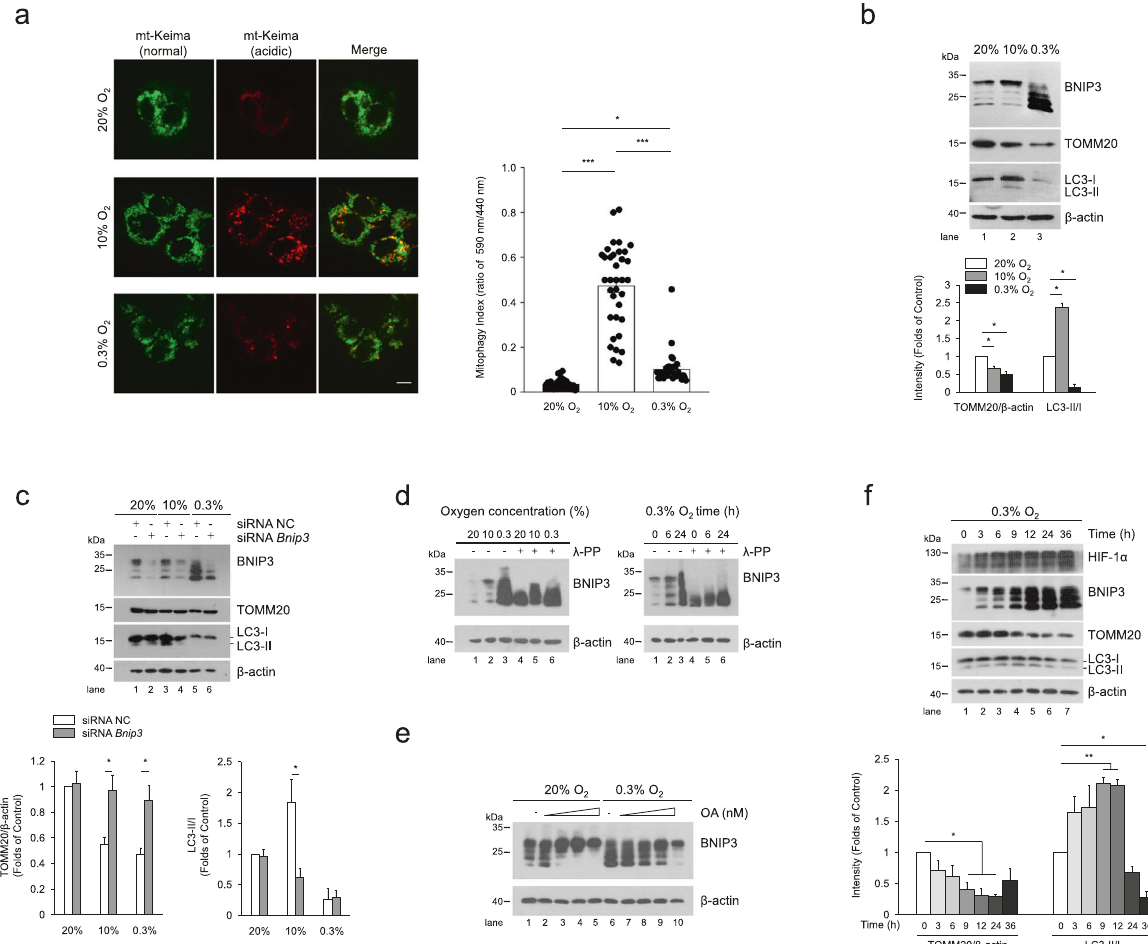
Fig. 1 BNIP3 phosphorylation is closely related to mitophagy. a PC12 cells stably expressing mt-Keima were exposed to 20% O 2 , 10% O 2 , or 0.3% O 2 for 24 h, and mitophagy was identi fi ed and quanti fi ed by the ratio of acidic (590 nm, red) to normal mitochondria (440 nm, green). Scale bar, 10 μ m. n = 35. b PC12 cells were treated same as ( a ), BNIP3, TOMM20 and LC3 were detected via western blotting. n = 3. c PC12 cells were transfected with negative control (NC) or Bnip3 siRNA for 48 h and then exposed to different oxygen concentrations for 24 h. The levels of BNIP3 mitophagy-related proteins were detected via western blotting. n = 3. d PC12 cells were exposed to different oxygen concentrations for 24 h or 0.3% O 2 for the indicated times. Cell lysates were treated with/without lambda phosphatase ( λ -PPase) for 1 h, followed by western blot analysis. e PC12 cells were exposed to 20% O 2 or 0.3% O 2 complemented with 0, 50, 100, 200, 500 nM okadaic acid (OA), and subjected to western blotting. f PC12 cells were exposed to 0.3% O 2 for the indicated times. Cell lysates were then western blotted for the indicated proteins. n = 3. The data are expressed as means ± SEM. * P < 0.05, ** P < 0.01, *** P < 0.001 versus the indicated